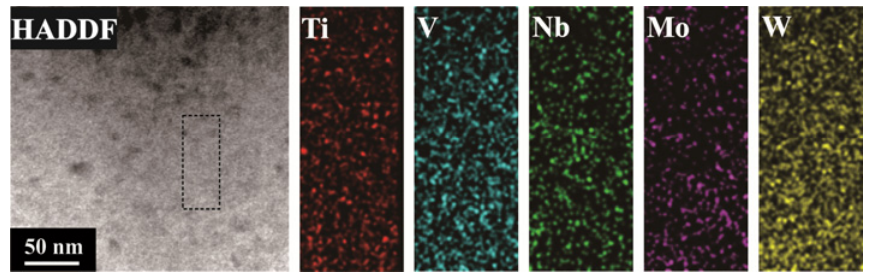
Fig. 6 HAADF-STEM image and corresponding transition metal element mappings of high-entropy (TiVNbMoW)C 4.375